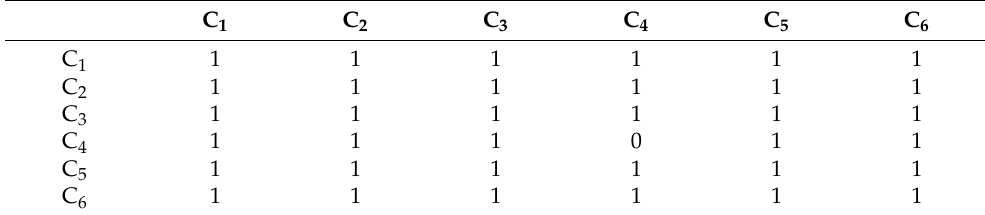
Table 8. Adjacency matrix of influencing factors.